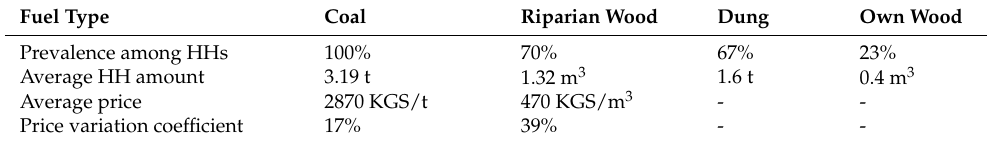
Figure 4. Energy carriers stored in the courtyards: ( a ) riparian wood and coal; ( b ) coal and dung. Ak-Tal Village, 2020. Table 1. Fuel types used in Ak-Tal Village, projected from the Ak-Tal Household Survey